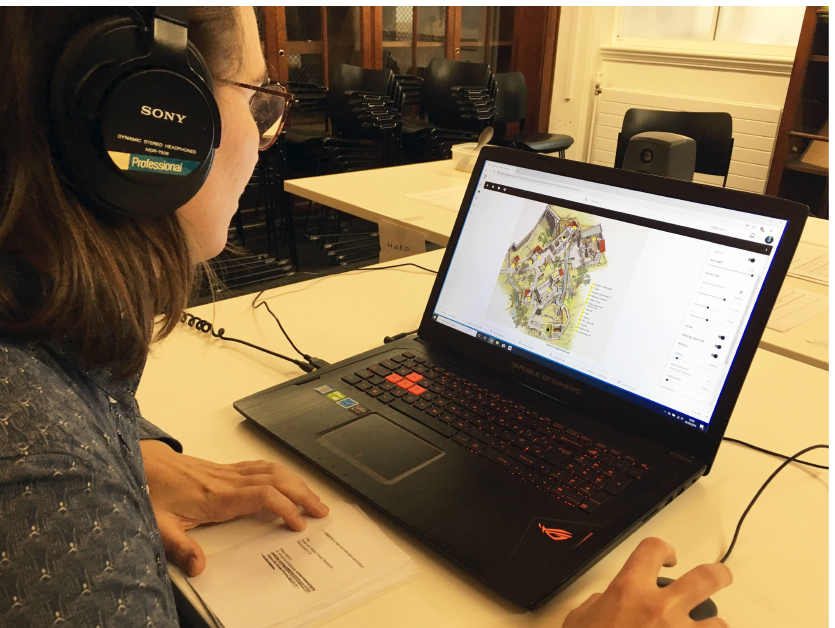
Figure 5. Participant using the Soundscape Create app for part 1 of the